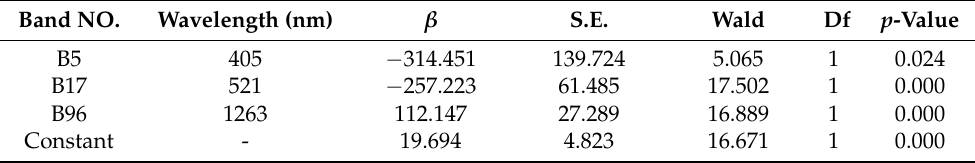
Table A1. Others class logistic model parameters derived from BLR and Wald test.